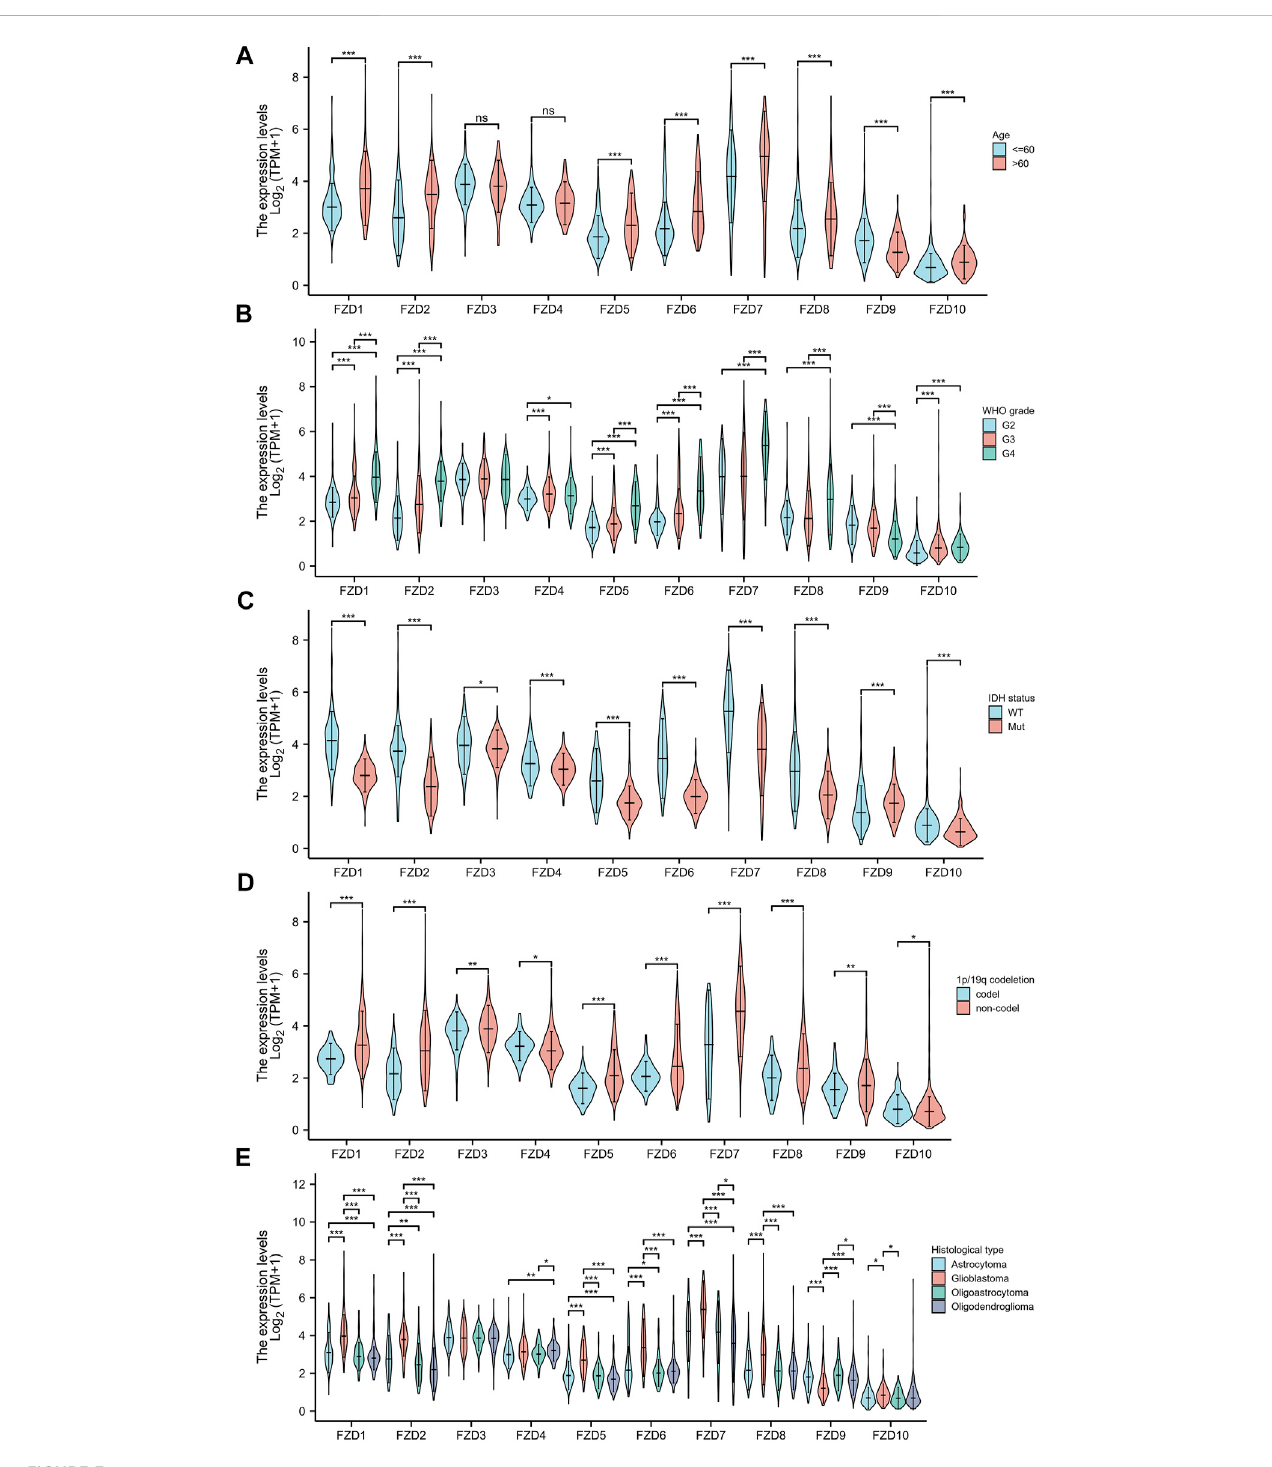
FIGURE 3 Association between FZD expression and clinical characteristics. (A) Age. (B) WHO grade. (C) IDH status. (D) 1p/19q status. (E) Histological